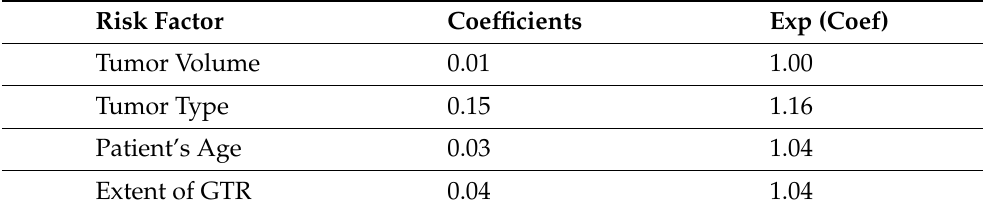
Table 7. Hazard Factor Weight.